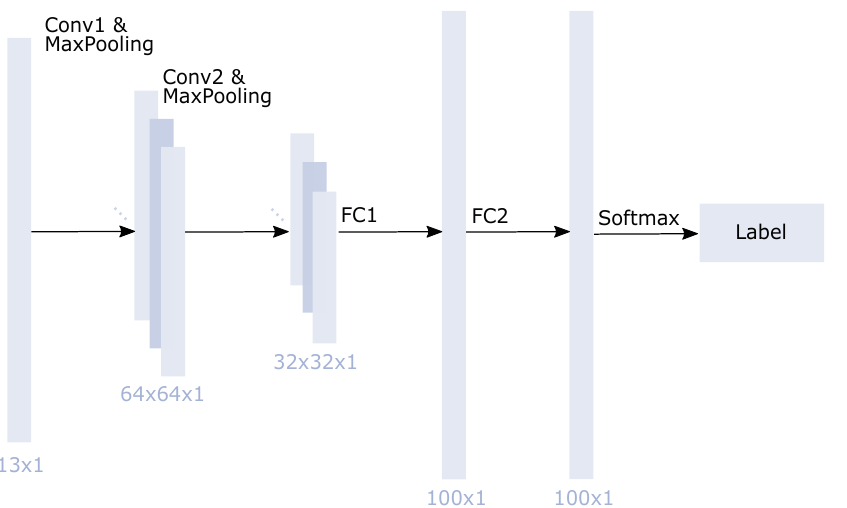
Figure 9. Flowchart of the 1D-CNN architecture for the 13 input features during the training process. The network includes convolutional (CONV), fully connected (FC), and max-pooling (MaxPooling) layers. At the end of the network, a softmax function is